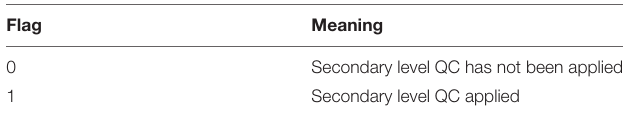
TABLE 3 | Secondary level quality control (QC) flags for chemical oceanographic data product development, as used by GLODAPv2 (Olsen et al., 2016) – these should not be used for cruise data